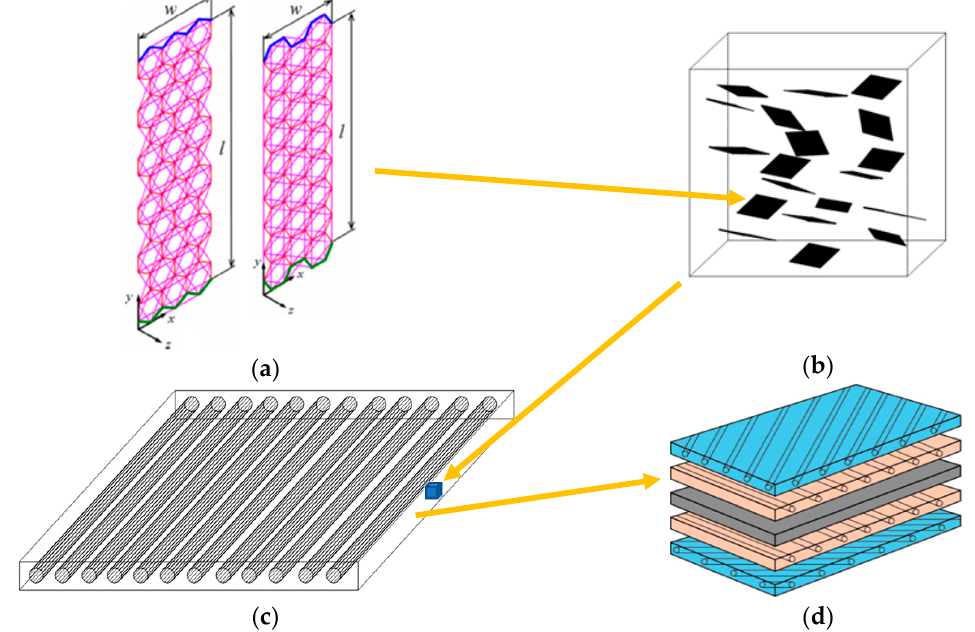
Figure 1. Modeling procedure (four-stage technique) of a laminated composite plate with graphene inclusions ( a ) finite element model of graphene in nanoscale; ( b ) homogenized model of hybrid matrix; ( c ) composite lamina with hybrid matrix; ( d ) composite plate with specific stacking sequence.